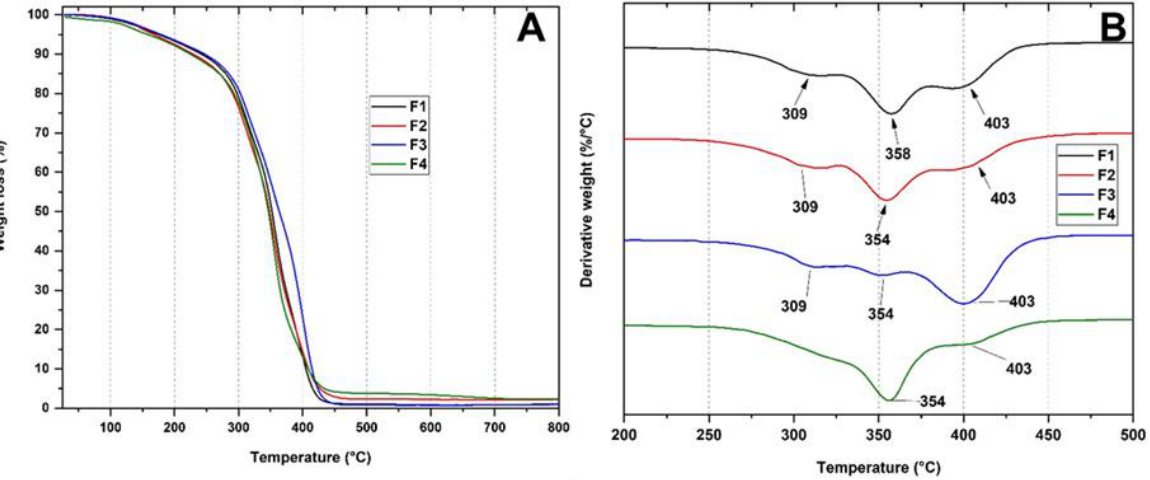
Figure 4. Thermal analysis of membranes PCL/PLA/TiO 2 /OEO. F1, 30% PCL/70% PLA; F2, 27% PCL/70% PLA/3% TiO 2 ; F3, 20% PCL:70% PLA:10% OEO; F4, 17% PCL:70% PLA:3% TiO 2 :10% OEO. ( A ) TGA ( B ) DTGA. ( A ) TGA ( B )